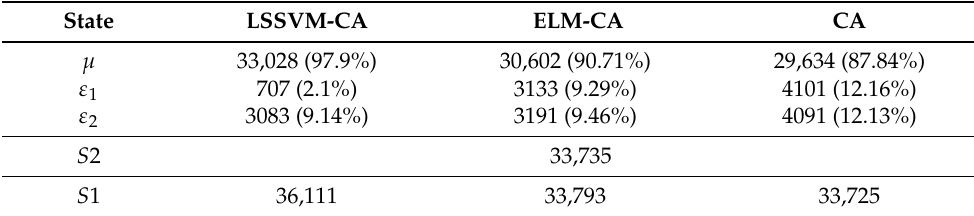
Table 1. Comparison between the actual and simulated